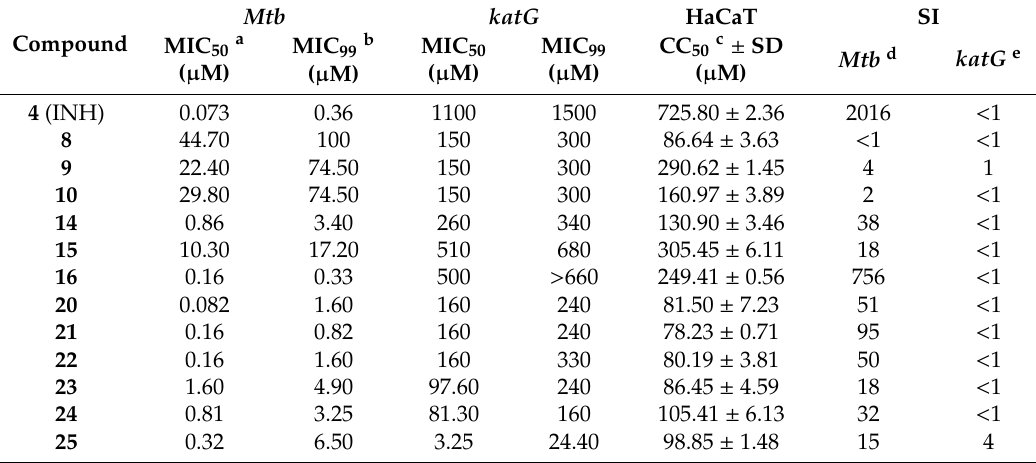
Table 2. In vitro antimycobacterial activity of compounds 8 – 10 , 14 – 16 , and 20 – 25 against Mtb and ∆ katG ; their cytotoxicity; and their selectivity